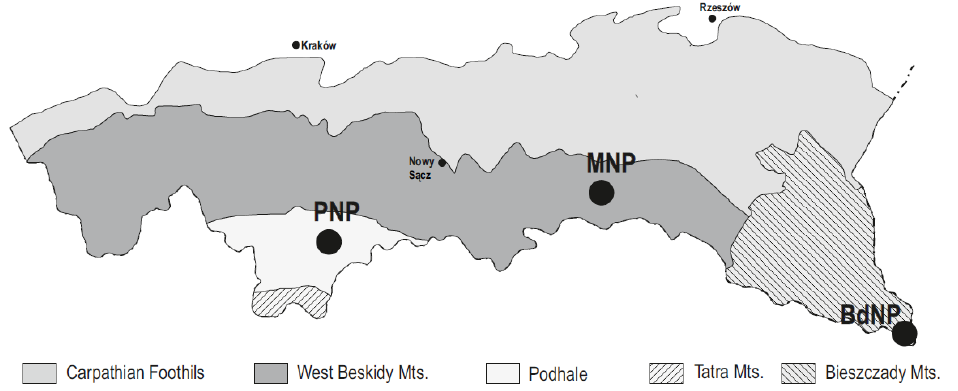
Figure 1. The location of the examined national parks in the Polish part of the Carpathian Moun- tains. BdPN — Bieszczady National Park, MNP — Magura National Park, PNP — Pieniny National Park.